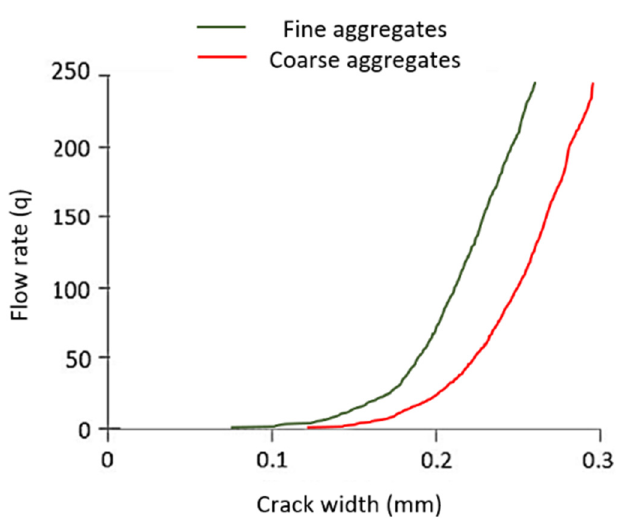
Figure 22. Flow rate behavior due to different aggregate size (Adapted with permission from reference [22]).